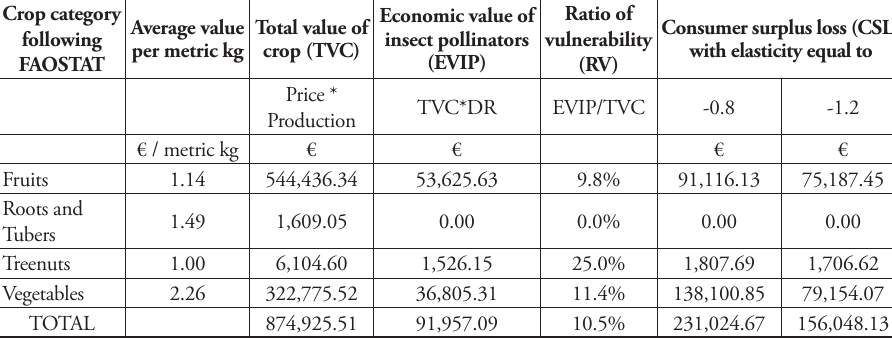
Table 7. Economic impact of insect pollination of the agricultural production used directly for human food and listed by the main